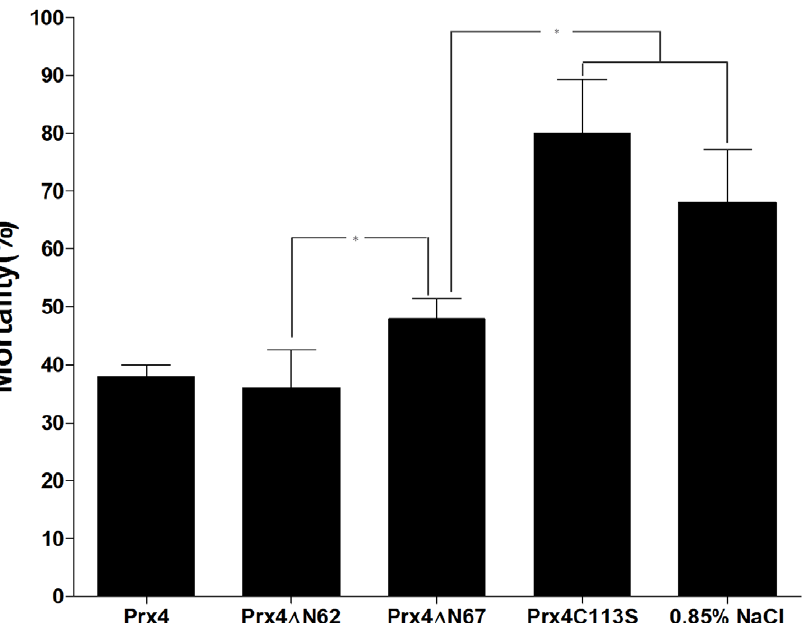
Figure 4. The functions of the three Prx4 proteins during bacterial challenge. Large yellow croakers were injected with Prx4, Prx4 D N62, Prx4 D N67, Prx4C113S or 0.85% NaCl and then challenged with a bacterial mixture. Fish mortality in each group was monitored for 5 days. The symbol * represents a significant difference in the mortality rate between the two groups injected with different proteins as indicated ( P , 0.05). ( Fig. 1C ). Since the basic functional unit of P. crocea Prx4 is a homodimer, this N-terminal b -sheet, which is situated at the dimer interface and involved in four main-chain hydrogen bonds ( Fig. 1D ), should be important for the peroxidase activity and biological function of this enzyme.